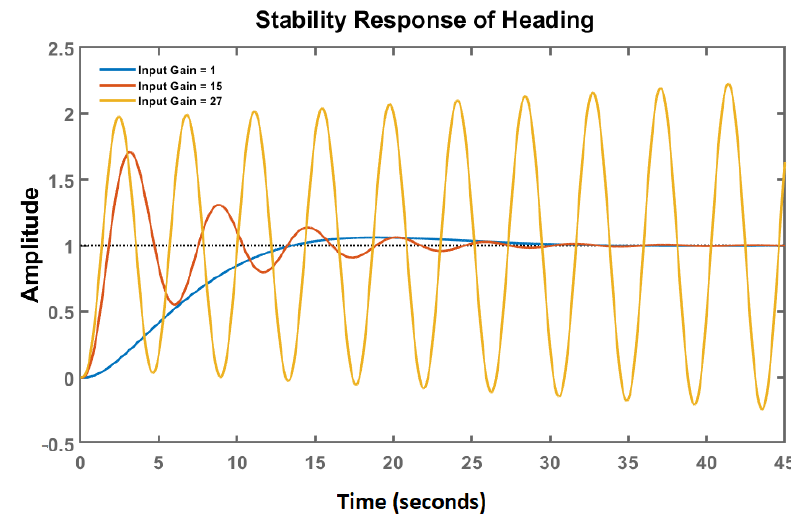
Figure 7. Head control system step response with varied